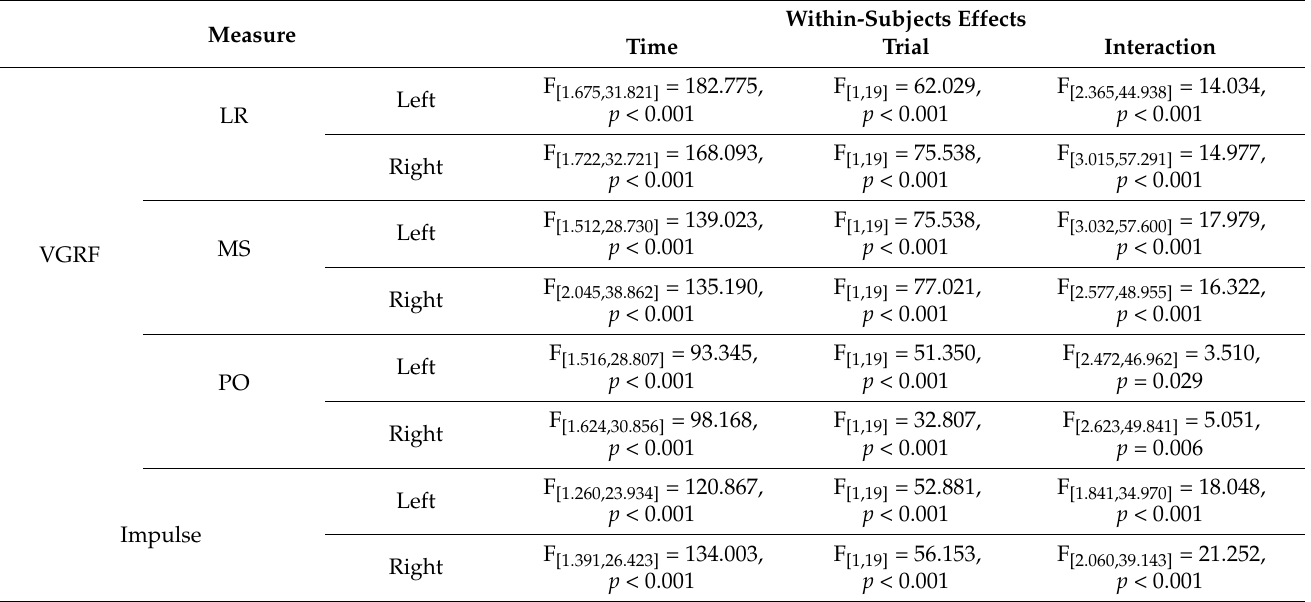
Table 1. The results of two-way repeated measures ANOVA for VGRFs and impulse. Measure Time